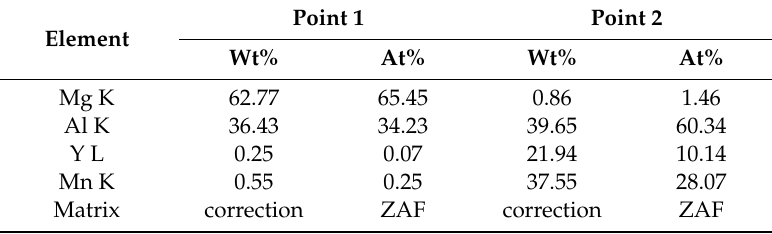
Table 3. The element contents of different intermetallic phase obtained by EDS.